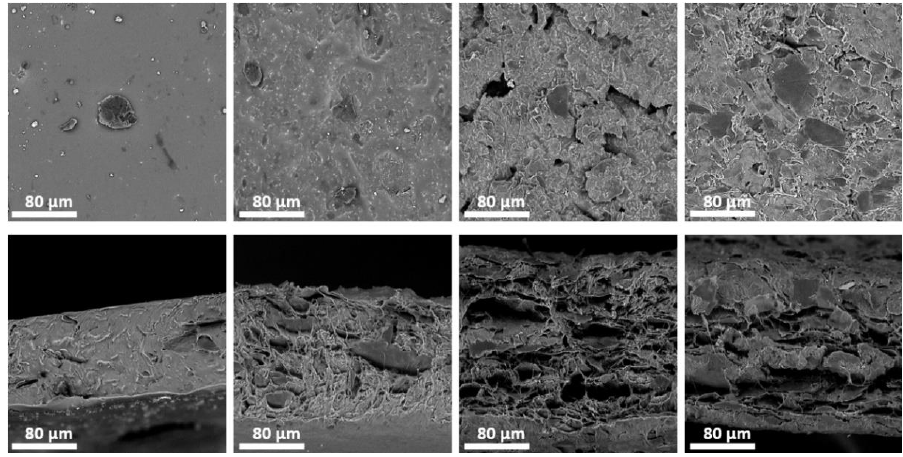
Figure 2. SEM micrographs of prepared composite layers, from left to right: 8, 15, 27 and 45 wt% graphene nanoplatelets content. Top: surface of the samples; on the surface of 8 wt% sample only single GNPs were visible, for 15 wt% outlines are visible from below silicone, for 27 and 45 wt% samples only a thin layer of silicone covers otherwise visible graphene structure. Bottom: cross-sections; for 8 wt% sample close to homogenous silicone structure is visible, which corresponds to observed insulating properties of the samples below 9 wt% graphene content.